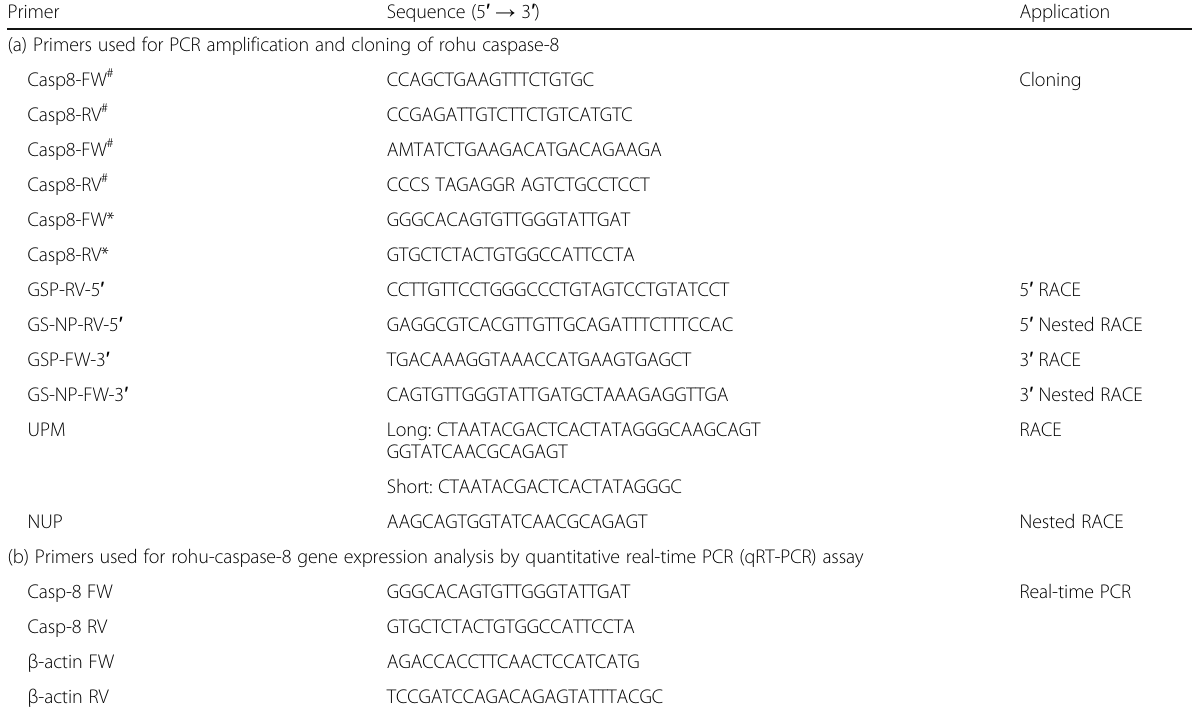
Table 1 Primers, their sequence, and application in this study Primer Sequence (5 ′ → 3 ′